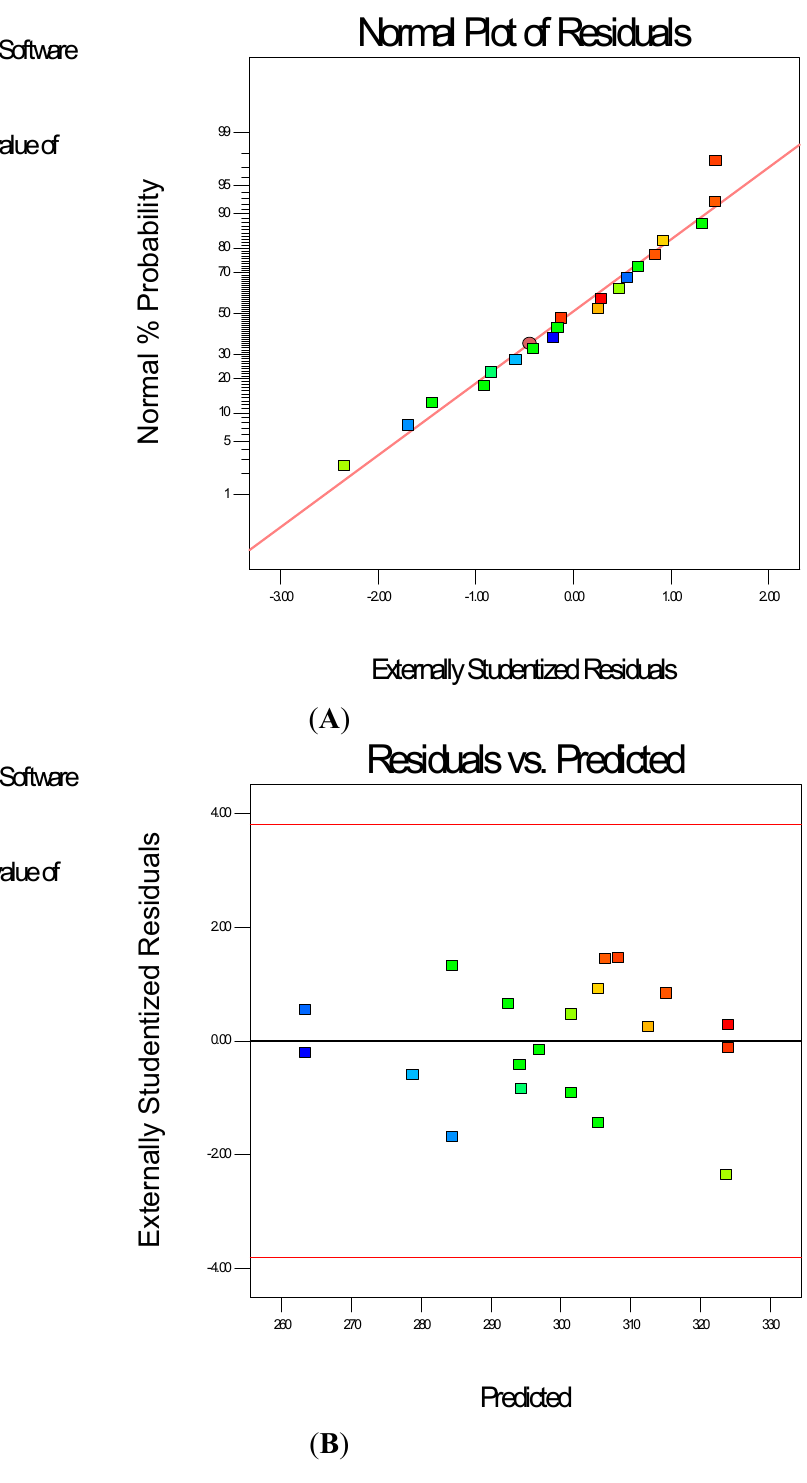
Figure 2. Diagnostic plots the particle size data of polylactide-based nanoparticles: ( A ) Normal Plot of Residuals; ( B ) Residuals vs. Predicted.